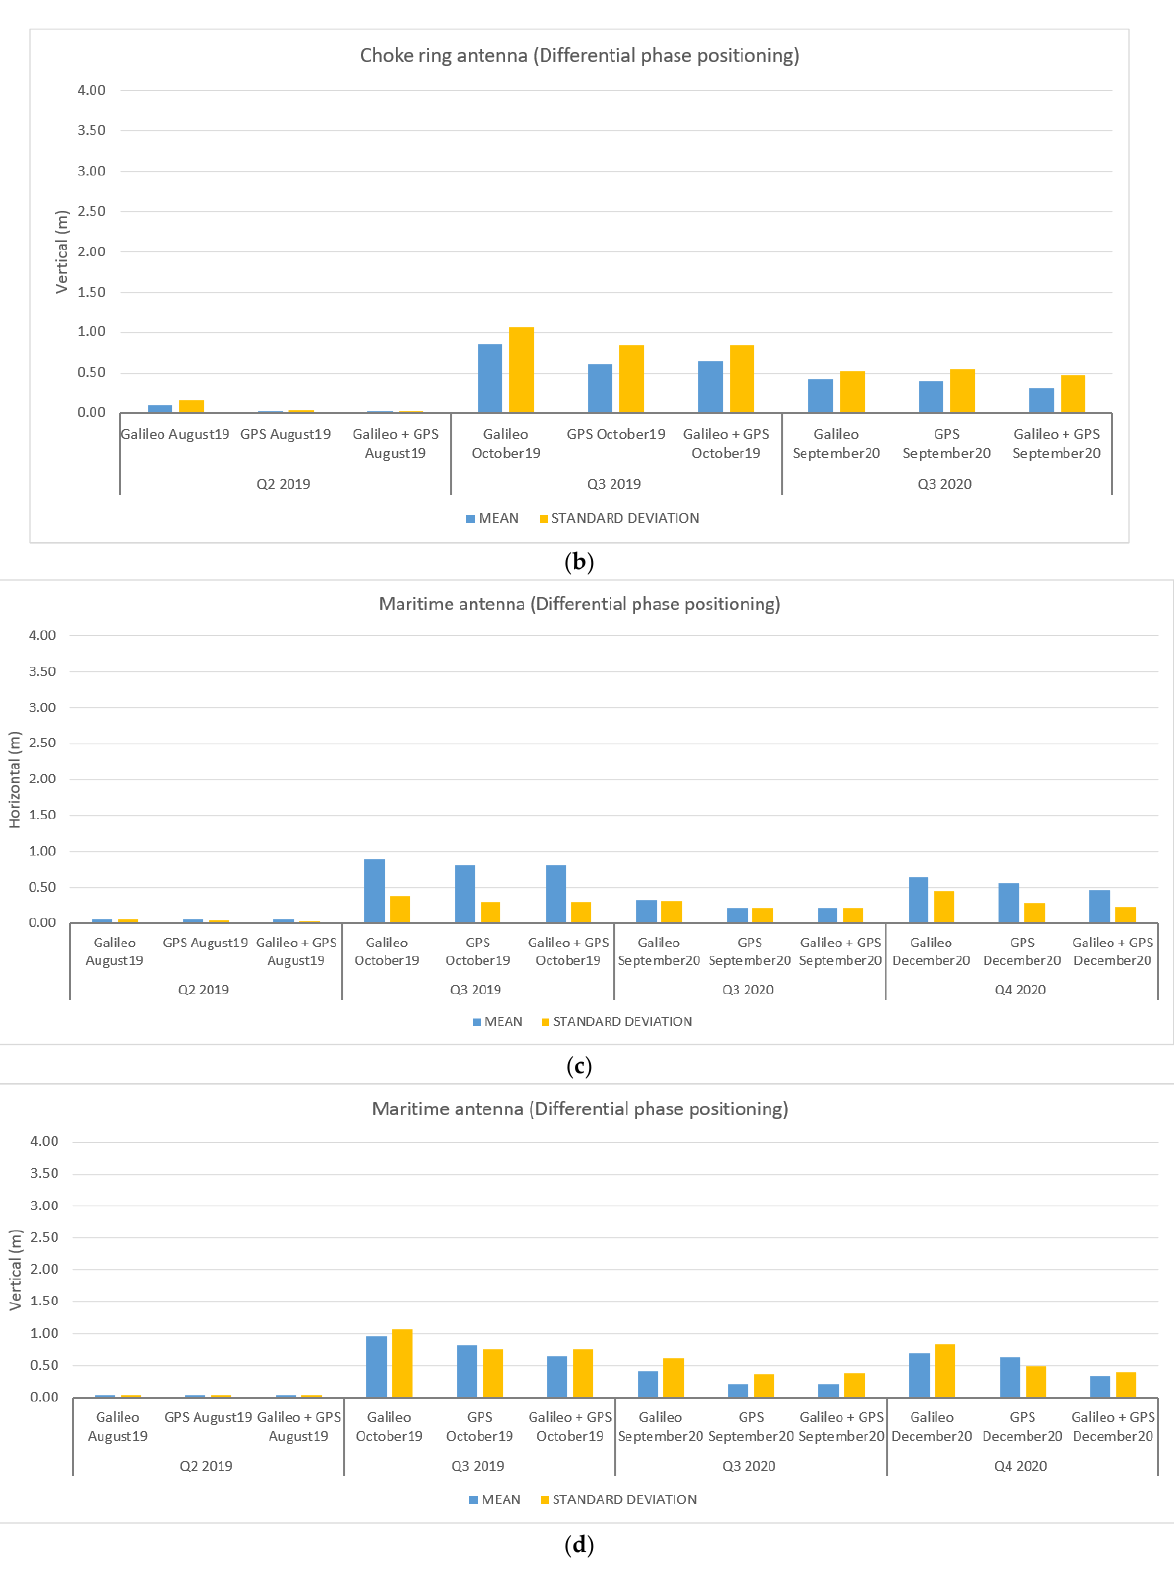
Figure 15. Horizontal and vertical mean values and standard deviations (in meters) for the different campaigns in maritime environments, using CSRS-PPP as reference and the triple frequency differential solutions: ( a ) horizontal and ( b ) vertical for the choke ring antenna; ( c ) horizontal and ( d ) vertical for the maritime antenna.